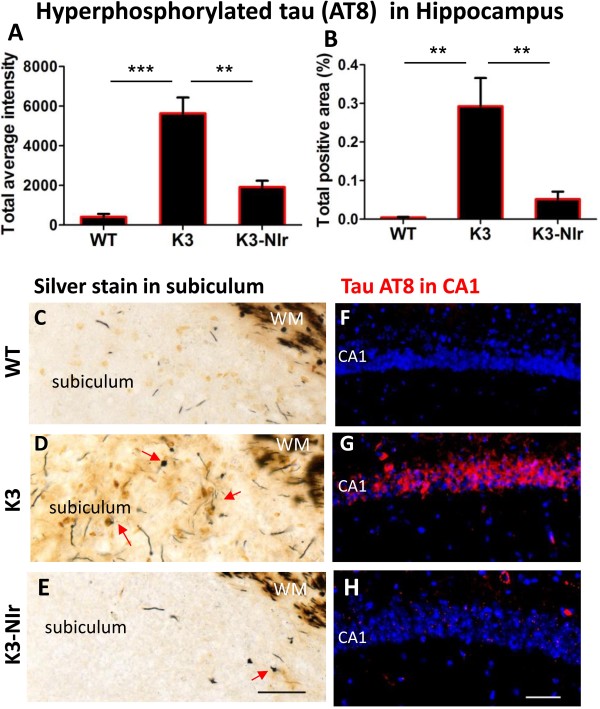
Effect of near-infrared light treatment on hyperphosphorylated tau and neurofibrillary tangles in the hippocampus of K3 mice. (A), (B) Quantification of tau AT8 immunolabelling, based on average labelling intensity (A) and labelled area (B). All error bars indicate standard error of mean. **P < 0.01, ***P < 0.001. (C), (D), (E) Representative photomicrographs of sections of the hippocampal subiculum area, stained with Bielschowsky silver stain to demonstrate neurofibrillary tangles (NFTs). Arrows indicate axonal swellings and NFTs. The classical silver stain also labelled axons in the white matter core (WM). (F), (G), (H) Representative micrographs of AT8 (red) labelling within hippocampal CA1 pyramidal neurons. Nuclei were labelled with bisbenzimide (blue). Scale bars = 50 μm; scale in (E) applies to (C) and (D), scale in (H) applies to (F) and (G). NIr, near-infrared light; WT, wildtype.